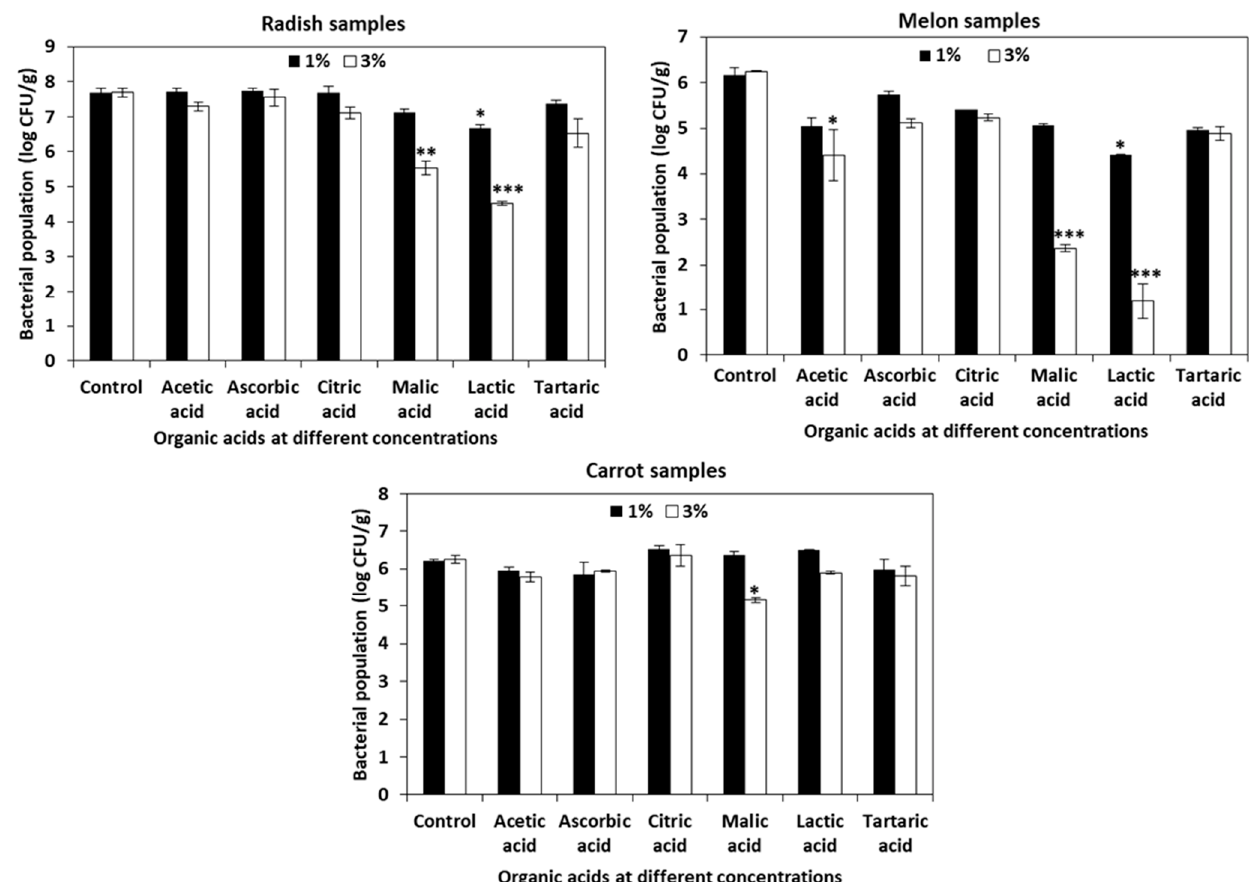
Figure 2. Efficiency of organic acids against L. monocytogenes in cut vegetable samples of radish, melon, and carrot. The organic acids acetic acid, ascorbic acid, citric acid, malic acid, lactic acid, and tartaric acid at a concentration of 1% and 3% were applied on radish, melon, and carrot samples and their effectiveness against L. monocytogenes was analyzed. The data obtained are the means ± SD from three independent experiments with triplicates. Statistical analysis ( t -test) was conducted using SigmaPlot. For t-test analysis, the values of organic acids-treated cut vegetable samples were compared with those of the untreated cut vegetable control samples. An asterisk indicates significant differences compared with the control (* p < 0.01, ** p < 0.001, *** p < 0.001).